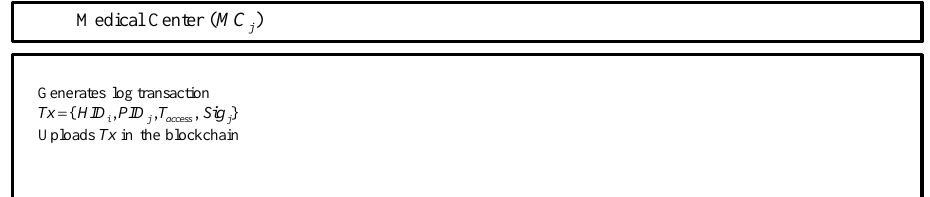
Figure 8. Log transaction uploading phase of the proposed